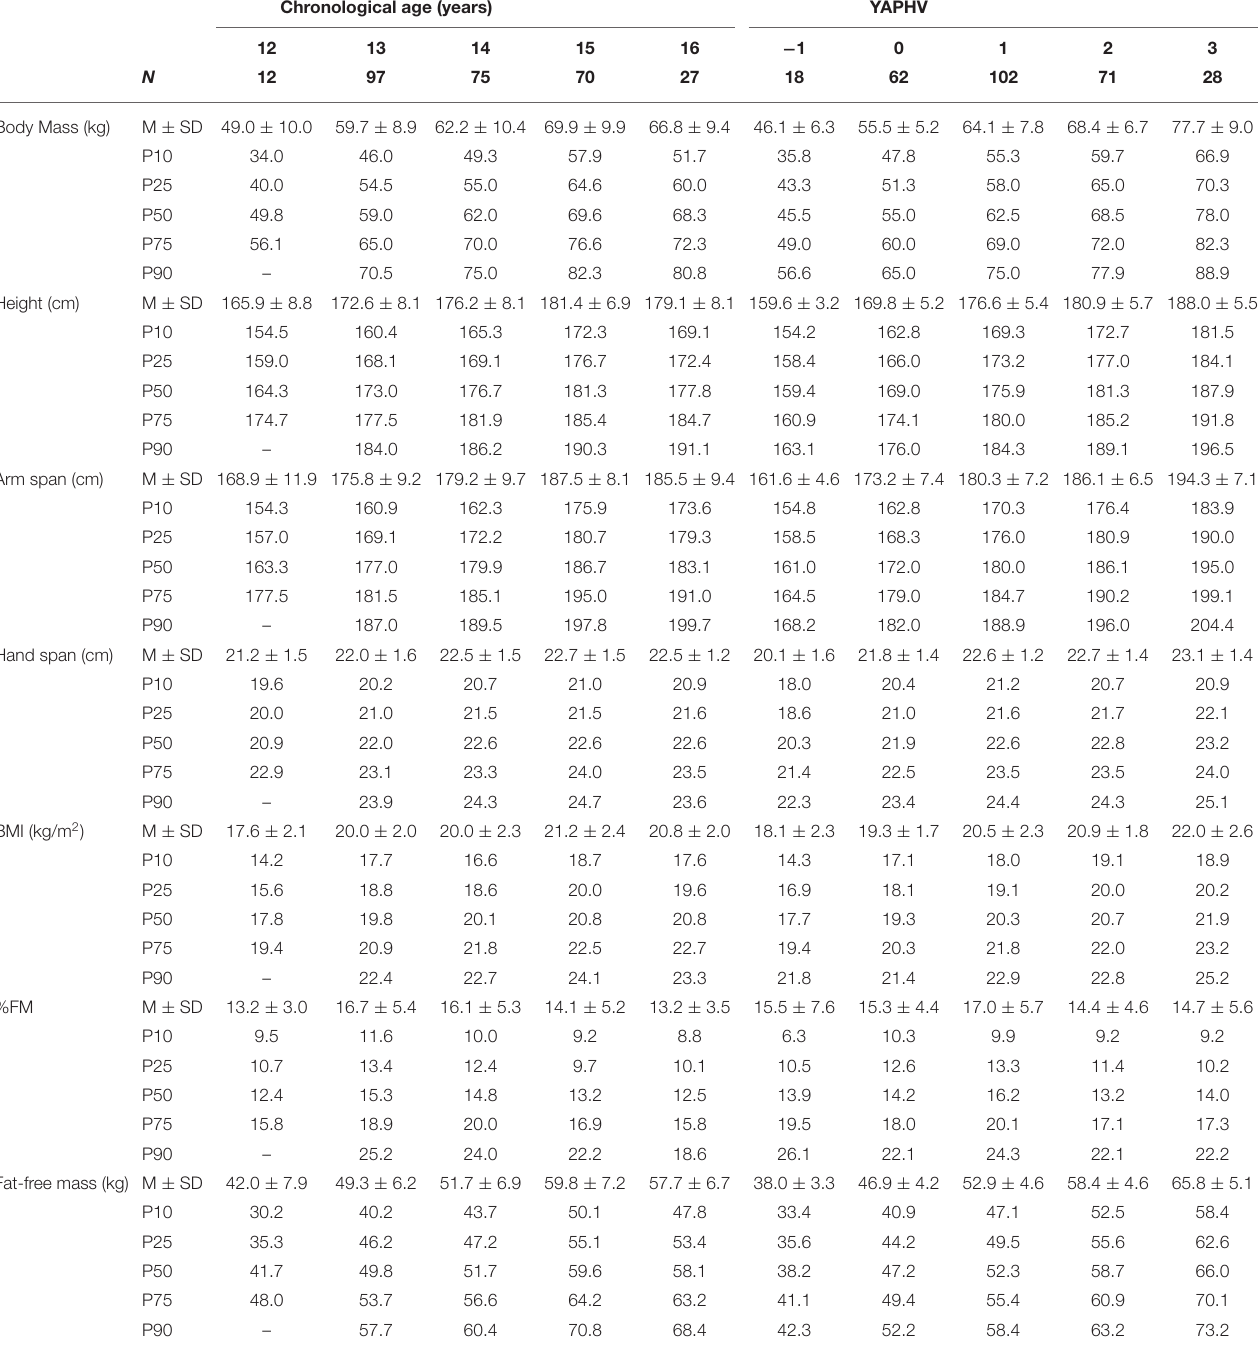
TABLE 3 | Descriptive statistics (mean ± SD) and reference values (10th, 25th, 50th, 75th, and 90th percentiles) for morphology of young Portuguese male basketball players, according to their chronological age and maturity